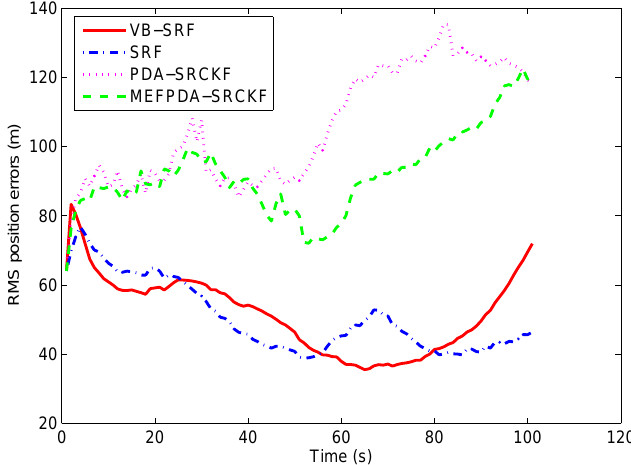
Figure 6. RMS target position errors with correct clutter probability in Scenario